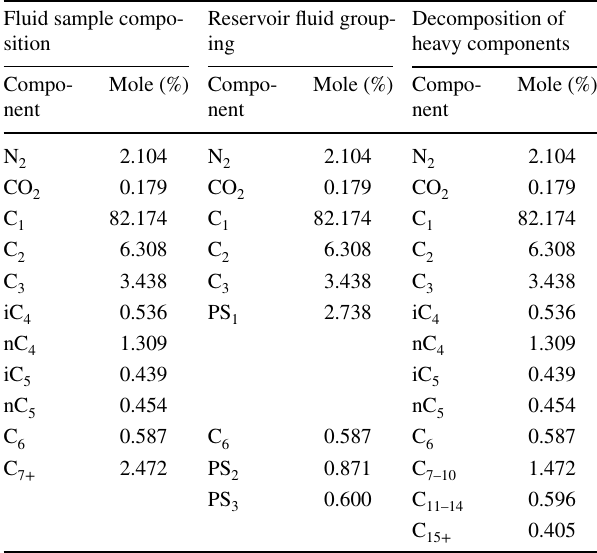
Table 4 Fluid sample composition, reservoir fluid grouping to the 9 components and decomposition of heavy components into three pseudo-components with the help of exponential distribution function Fluid sample compo- Reservoir fluid group- Decomposition of sition ing heavy components